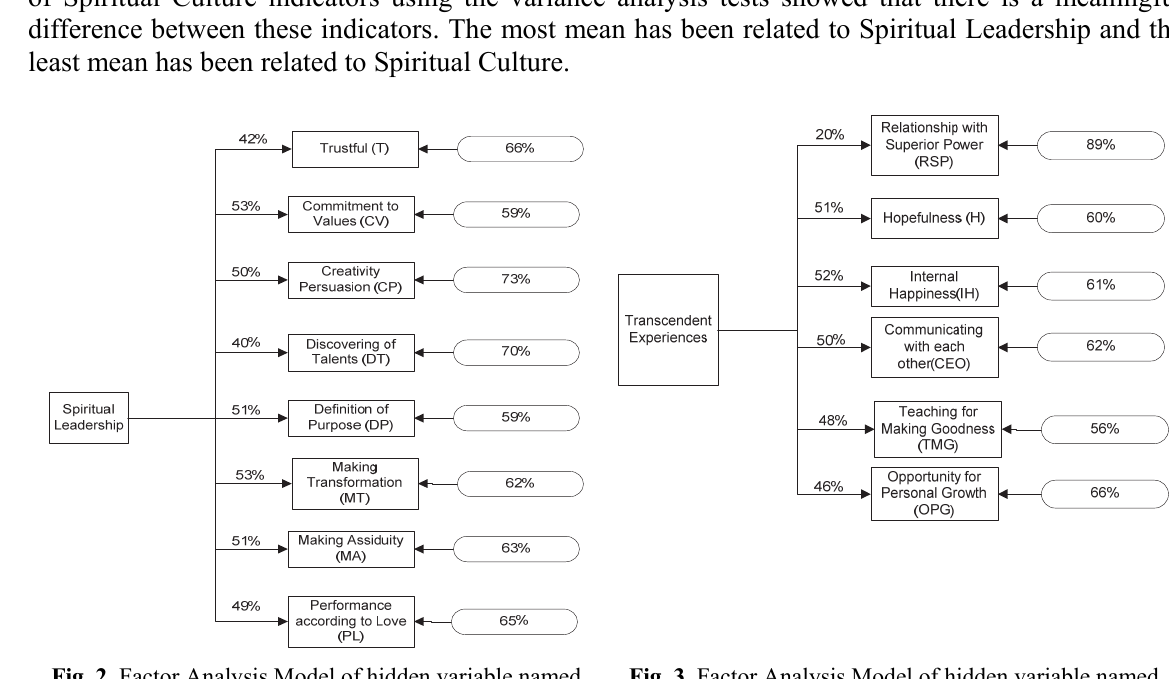
Fig. 3. Factor Analysis Model of hidden variable named Transcendent Experiences (The second indicator of Spirituality and Ethics in Higher Education)